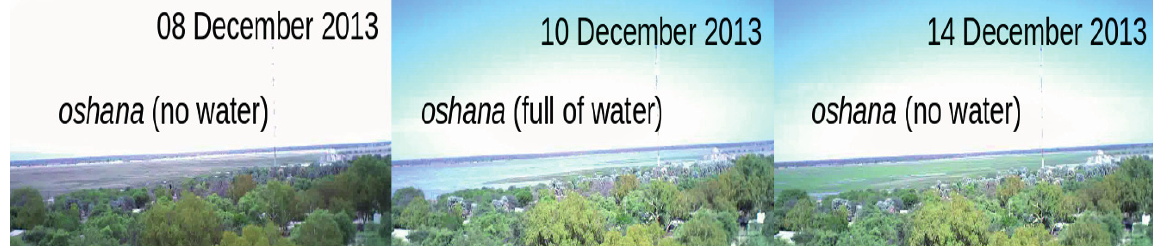
Figure 1. An example of the dramatic changes in the water extent in the oshana over the period of a week. These photos were taken from a water tower at the University